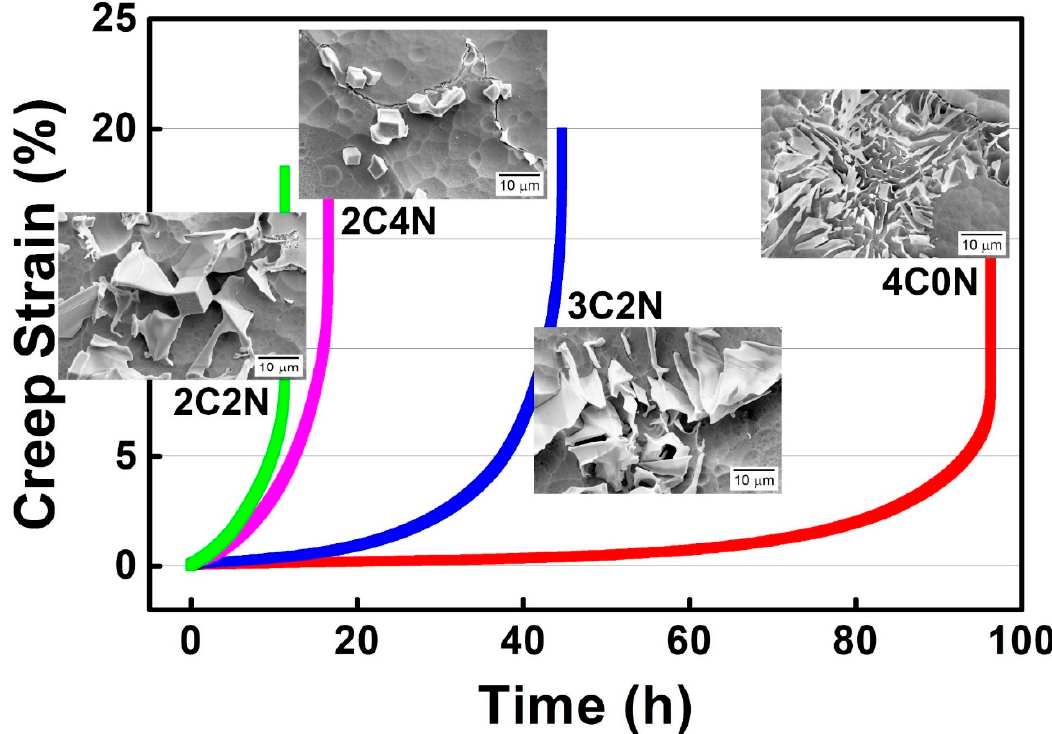
Figure 11. Schematic image showing the relationship between creep property and the microstructure of novel cast austenitic heat-resistant steels at 1000 °C and 50 MPa.